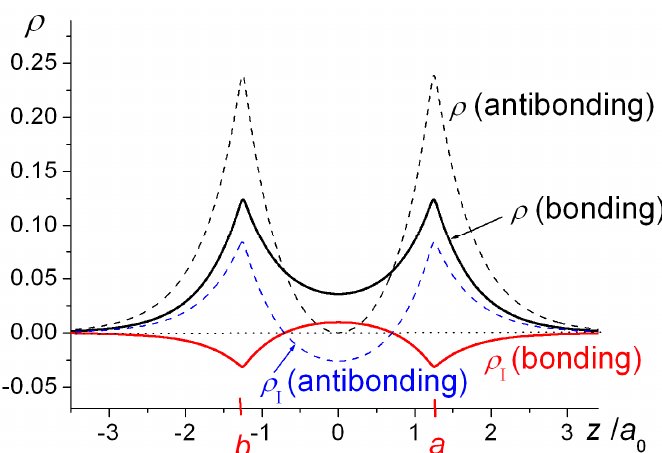
Figure 2. Total electron densities ( ρ ) of bonding (solid black line) and antibonding (dashed black line) states of H 2 + at R = 2.5 a 0 with ζ = 1 and corresponding interference contributions ( ρ I ), shown in red and blue, respectively, as functions of internuclear coordinate z .